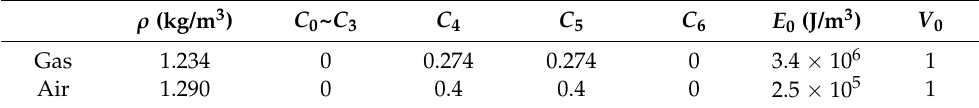
Table 2. Parameters of gas and air.